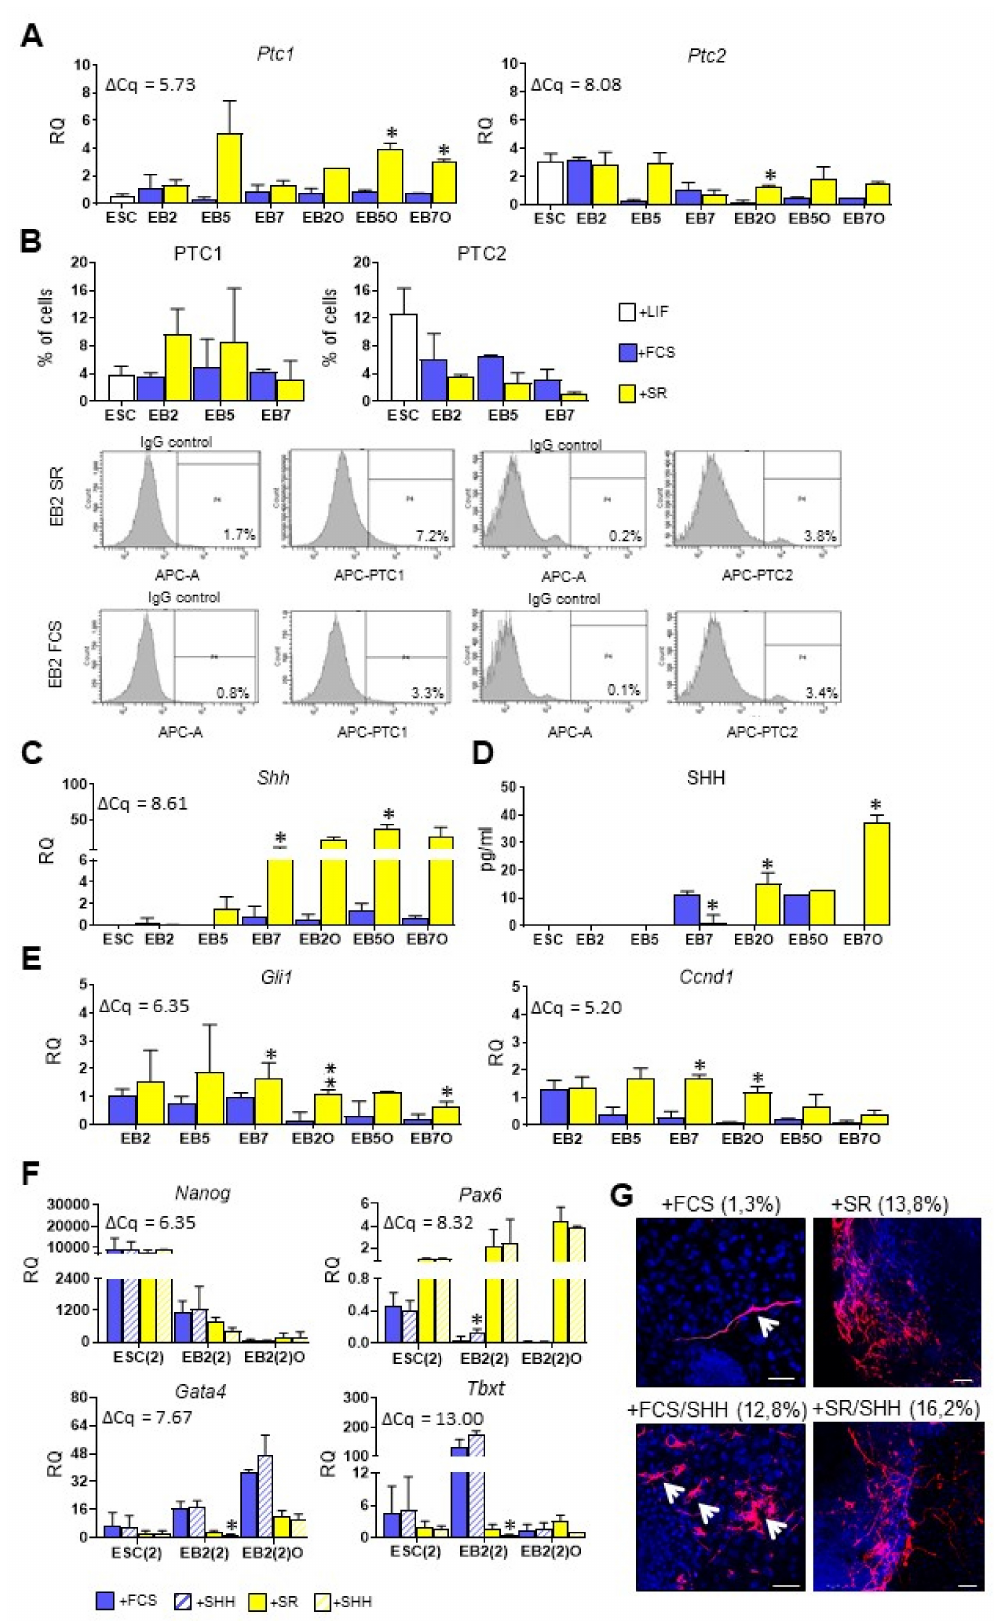
Figure 7. Analysis of SHH, its receptors and SHH pathway activity in undifferentiated and differentiating mouse ESCs cultured in medium supplemented either with FCS or SR. ( A ) Expression of SHH receptors: Ptc1 and Ptc2 in ESCs, EBs